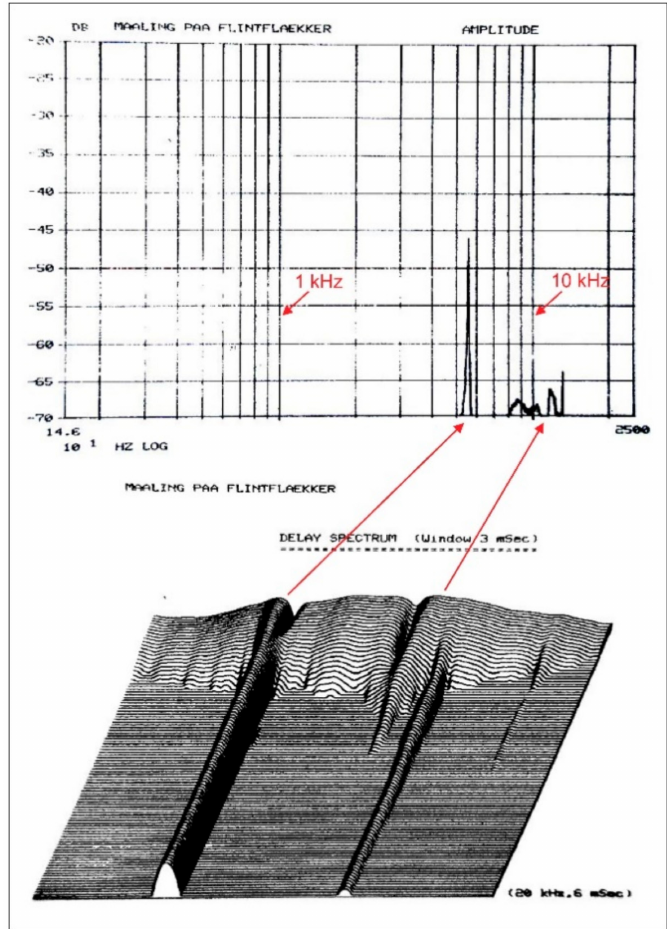
Figure 3. Detailed measurement of sample 2 from site 4 (see Figure 2) in the Bang & Olufsen Sound Laboratory, showing the main peak of this flint blade between 5 and 6 kHz ( top ), and the delay of its resonance over 6 msec after excitation ( bottom ). Measurements by Hugo Rasmussen 1982. Graphic: